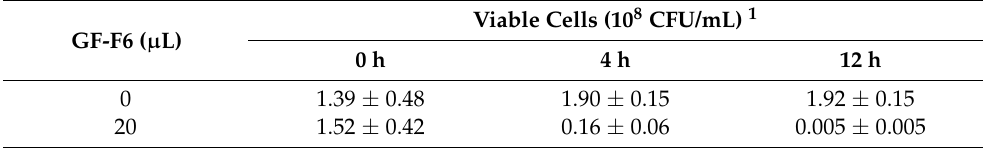
Table 1. Bactericidal activity of antibiotic in rhubarb.